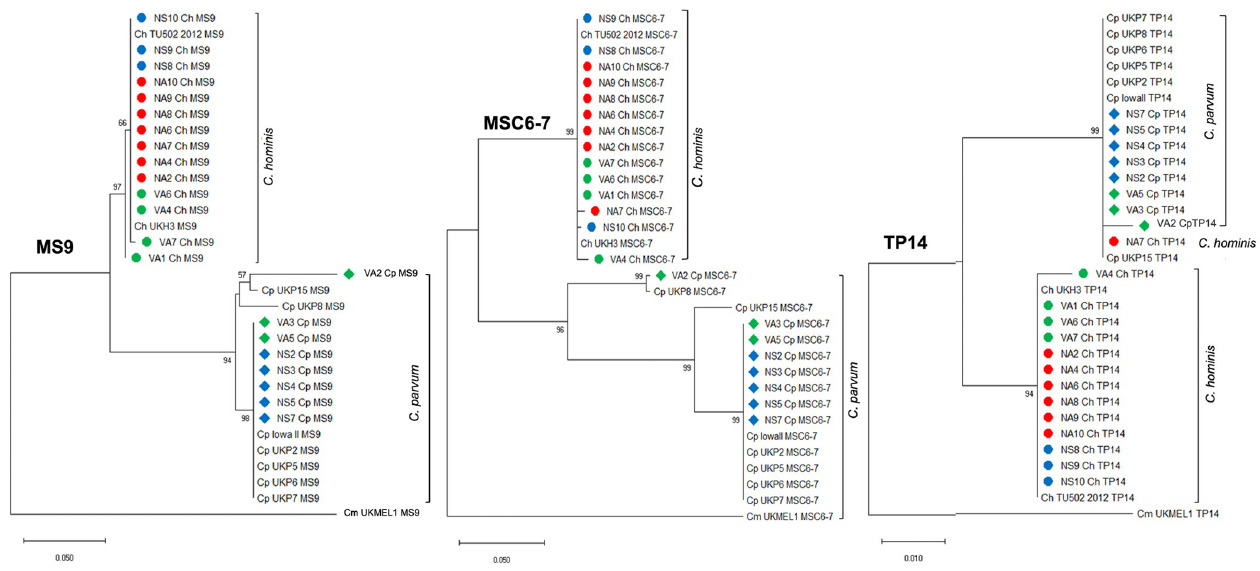
Fig 5. Phylogenetic trees constructed with the sequences of MS9 , MSC6 – 7 , and TP14 markers genes.